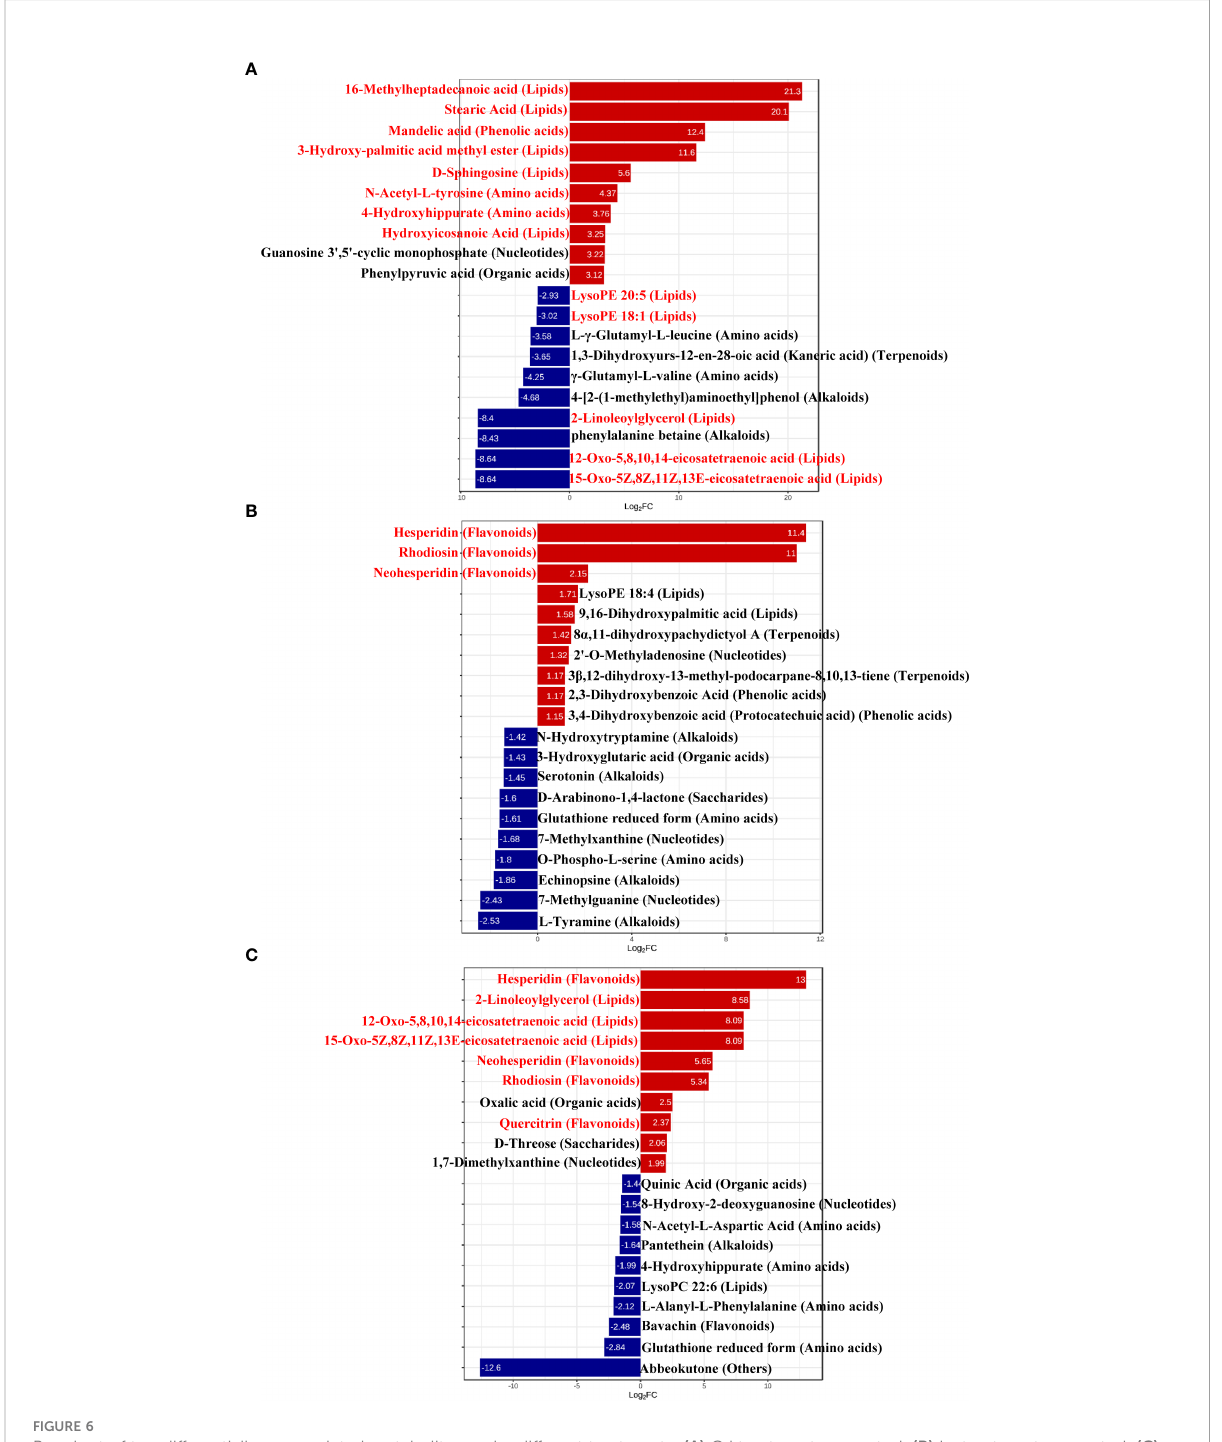
FIGURE 6 Bar chart of top differentially accumulated metabolites under different treatments: (A) Cd treatment vs. control, (B) La treatment vs. control, (C) Cd + La treatment vs. Cd treatment. The ordinate is the name of the DAMs; the abscissa is the Log 2 FC (fold change), representing the logarithmic fold change of metabolites in two groups. The red bar denotes the metabolites up-regulated, and the blue bar signi fi es the metabolites down- regulated. Red letters stand for metabolites for subsequent